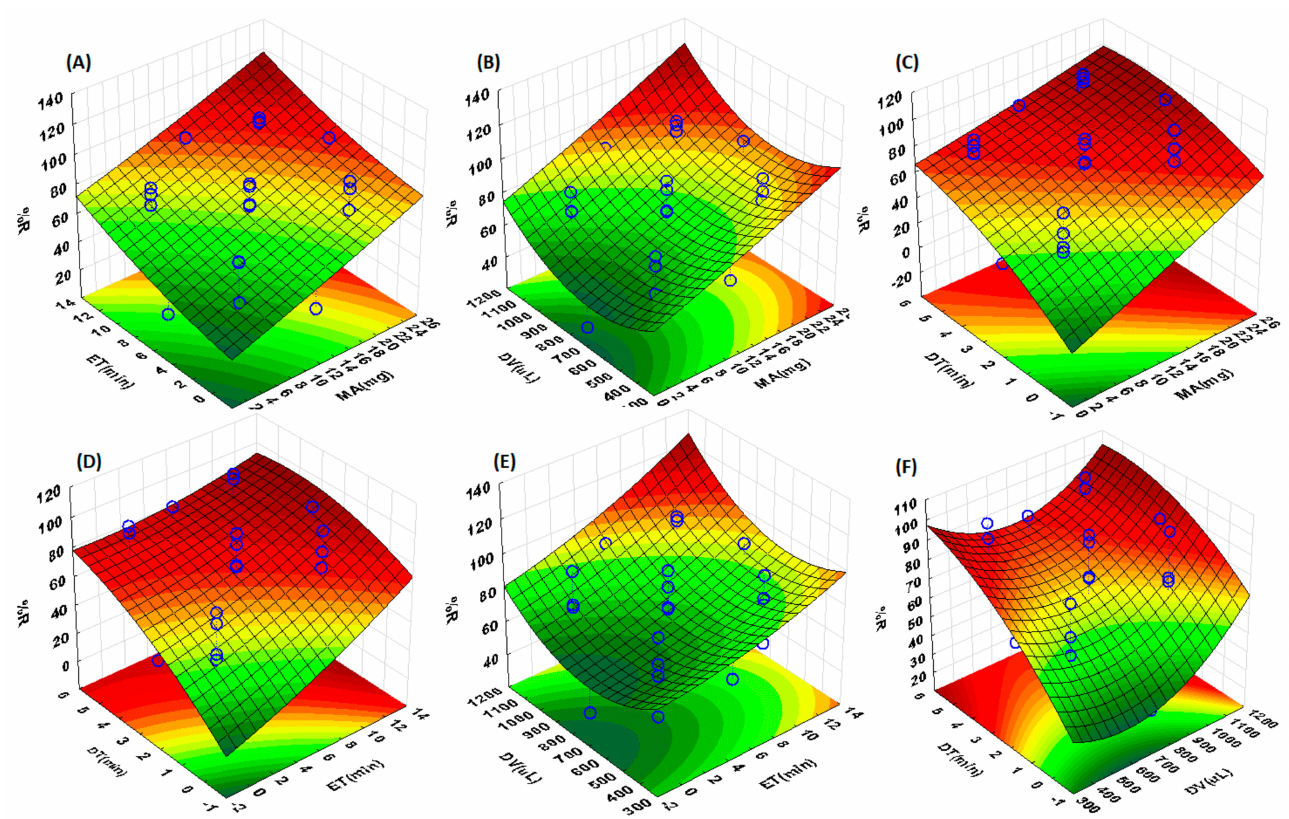
Figure 7. 3D response surface plots showing effects of on percentage recovery (%R) of ACT. The individual figures represent the interactions between ( A ) extraction time (ET) and mass of adsorbent (MA), ( B ) desorption volume (DV) and MA, ( C ) desorption time (DT) and MA, ( D ) DT and extraction time (ET), ( E ) DV and ET, ( F ) DT and